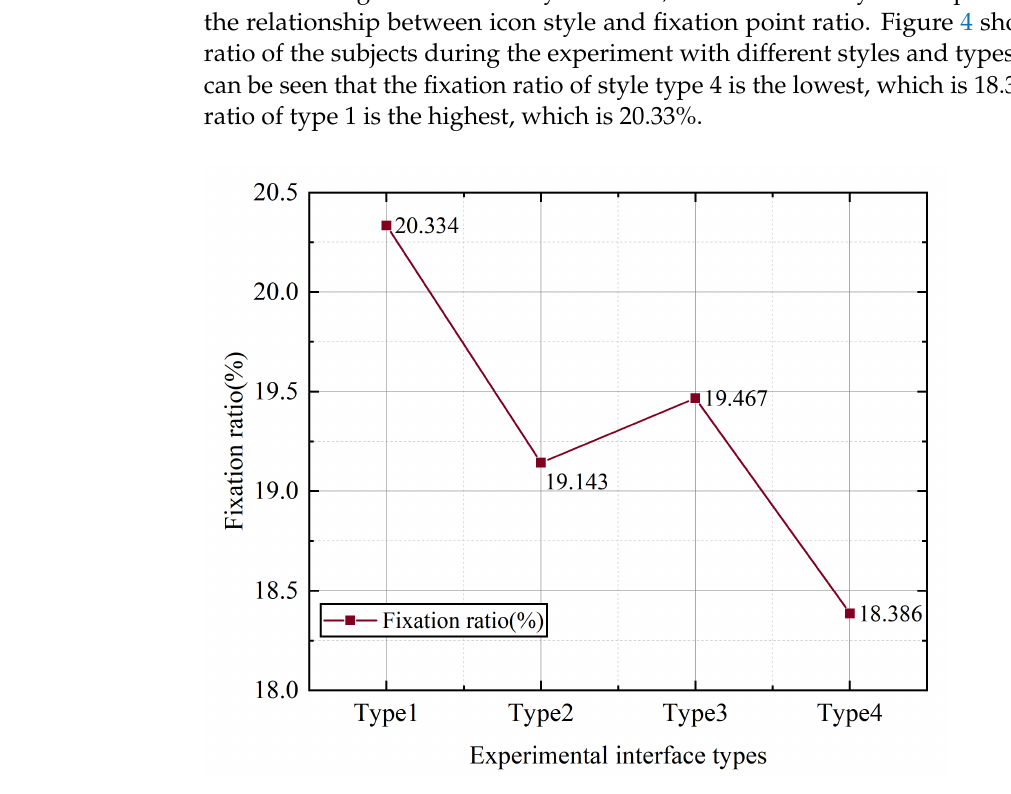
Figure 4. The average value of the gaze point ratio of different styles of